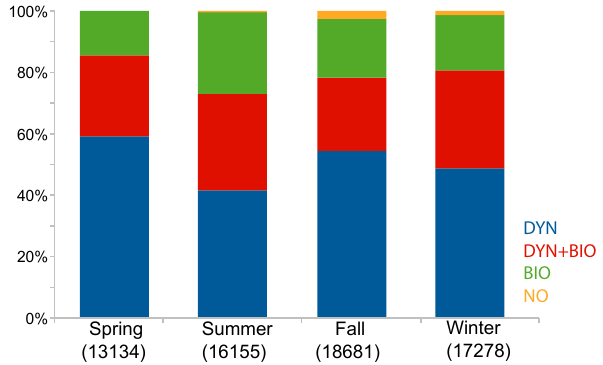
Fig. 7. The proportion of dominant processes identified for each season (in %). Note that there is a sampling bias toward winter and fall, spring being less sampled (the number of observations is indi- cated in parenthesis).